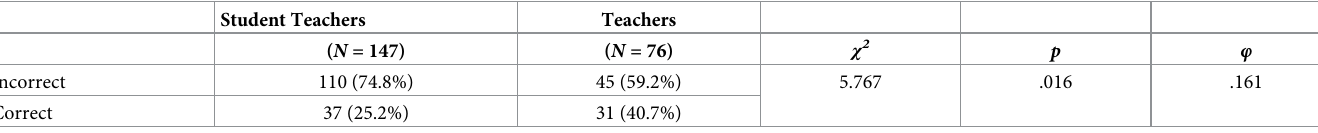
Table 1. Differences in accuracy in identifying target children between student teachers and